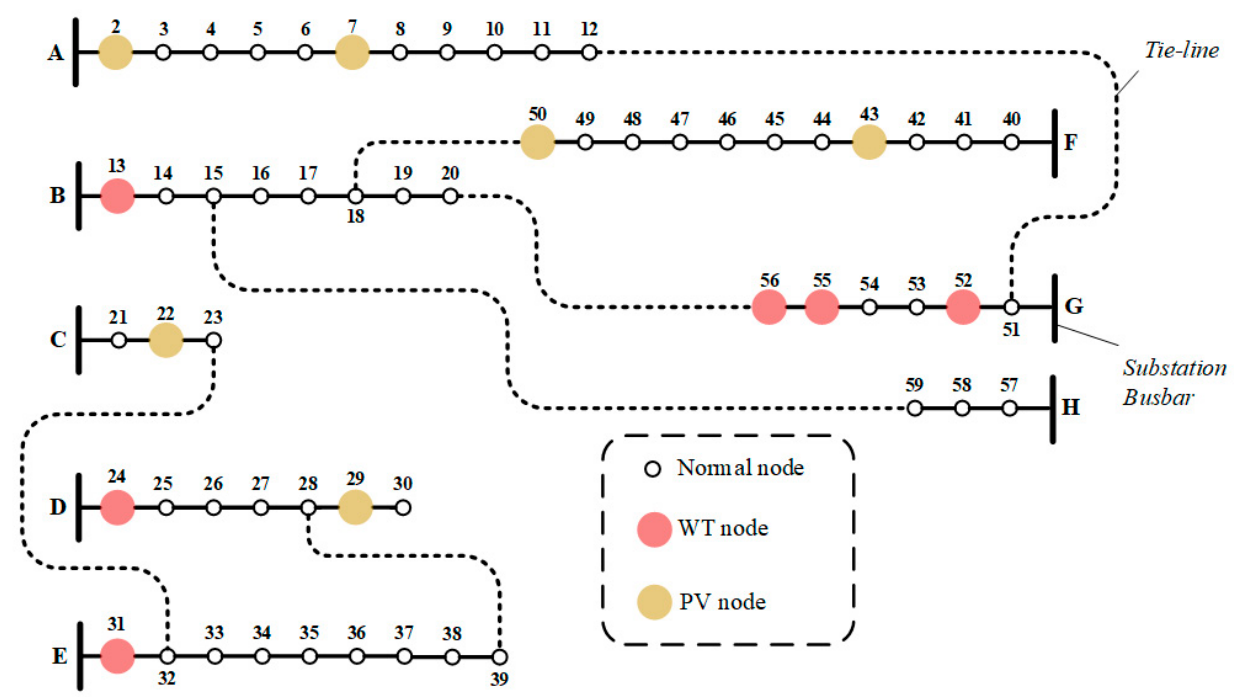
Figure 7. 59-node real distribution network in Cairo.